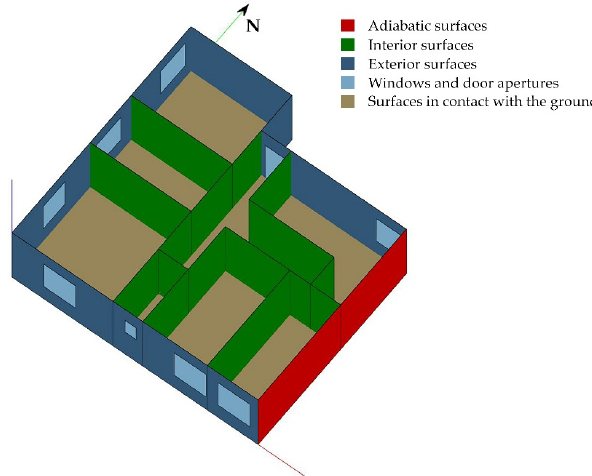
Buildings 2022 , 12 , x FOR PEER REVIEW Figure 2. Single family attached house model and type of surfaces. Figure 2. Single family attached house model and type of surfaces.